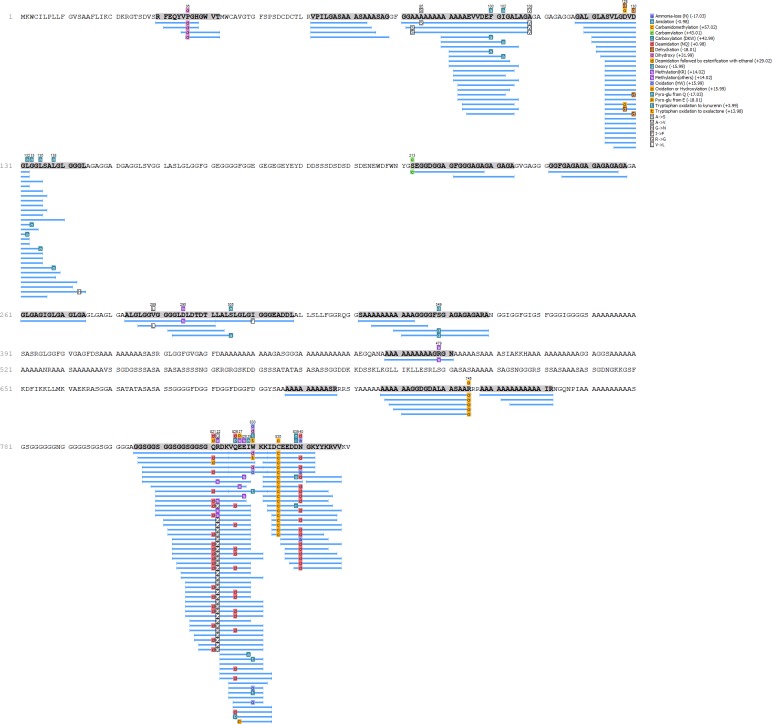
HavB - Hic74 coverage.